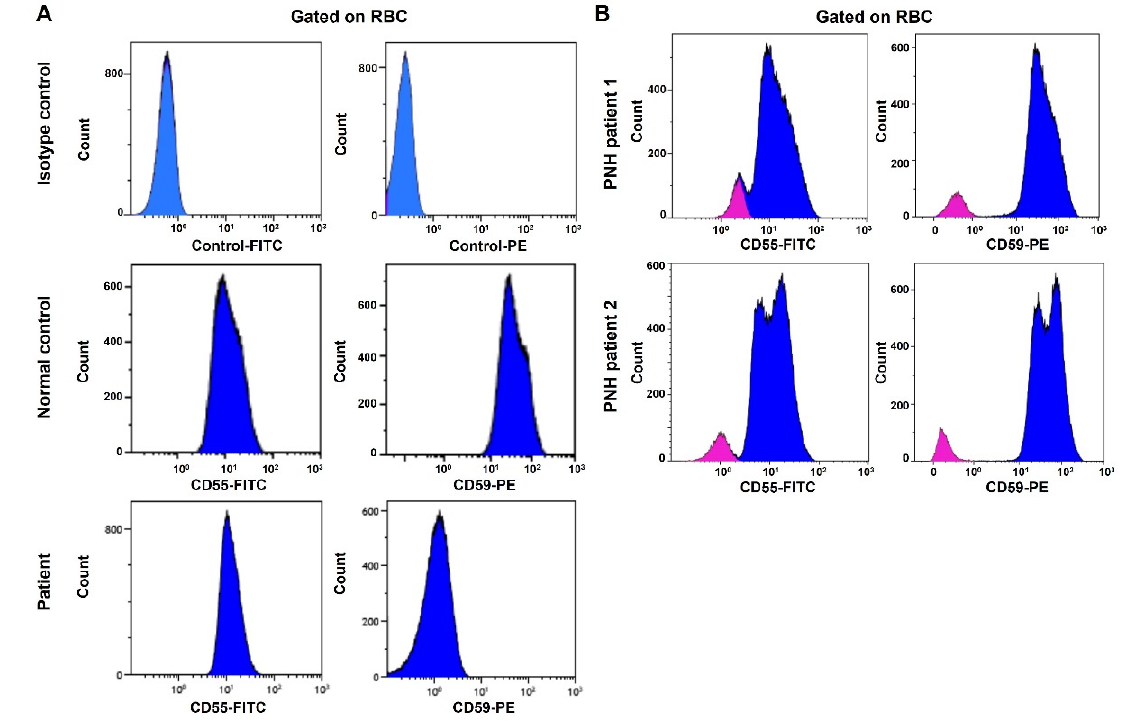
Figure 2. Flow cytometry analysis fails to detect CD59 protein expression on the surface of the patient’s RBCs. CD55 protein is expressed on the cell surface. ( A ) Top panel: RBCs stained with FITC and PE isotype control antibodies. Middle panel: RBCs from a normal control stained with anti-CD55-FITC and anti-CD59-PE antibodies. Bottom panel: RBCs from the patient stained with anti-CD55-FITC and anti-CD59-PE antibodies. ( B ) Flow cytometry analysis of CD55 and CD59 protein expression in PNH patients. RBCs from two PNH patients are stained with anti-CD55-FITC and anti-CD59-PE antibodies (Red: PNH clone; blue: normal RBCs).